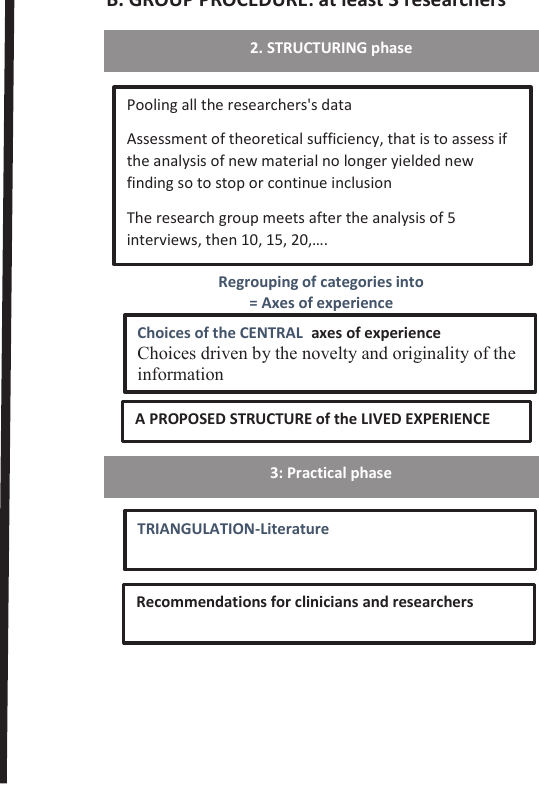
Figure 1. Data analysis